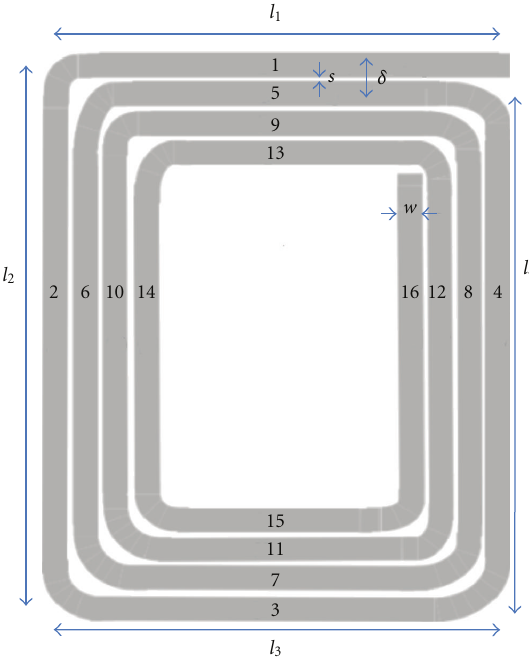
Figure 1: Rectangular planar spiral